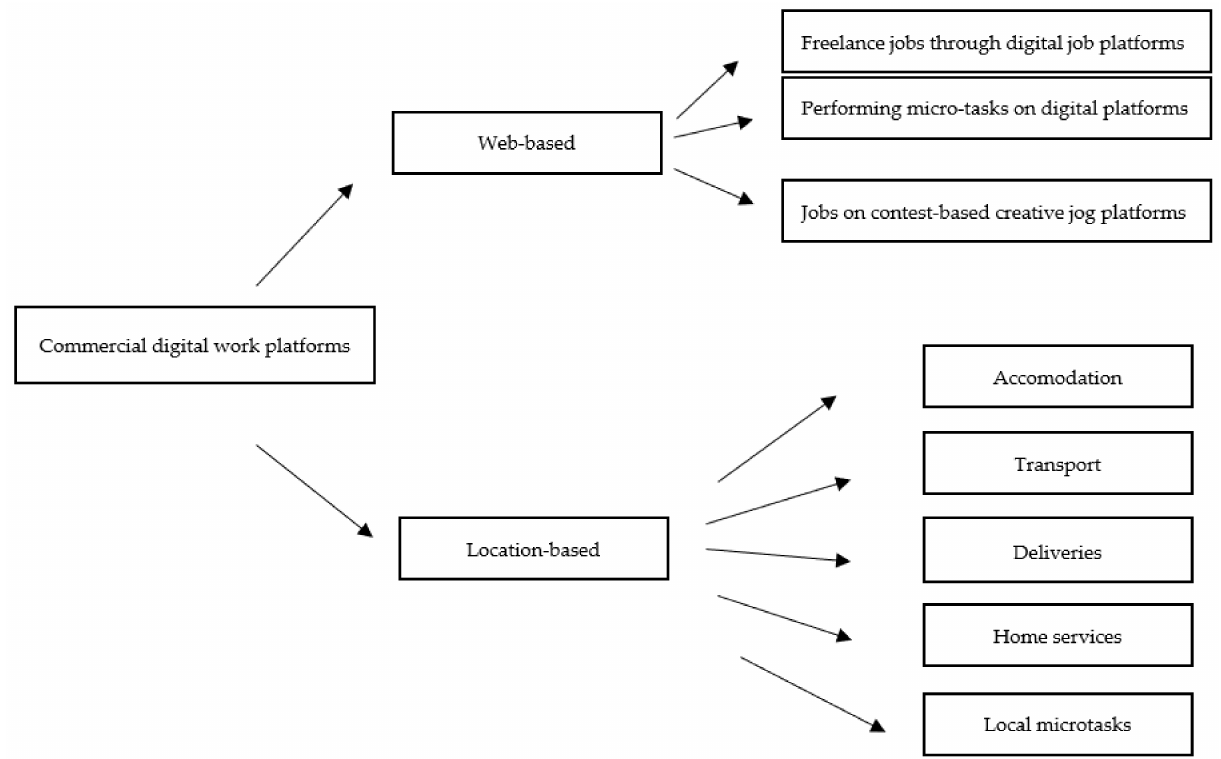
Figure 1. Types of digital labor